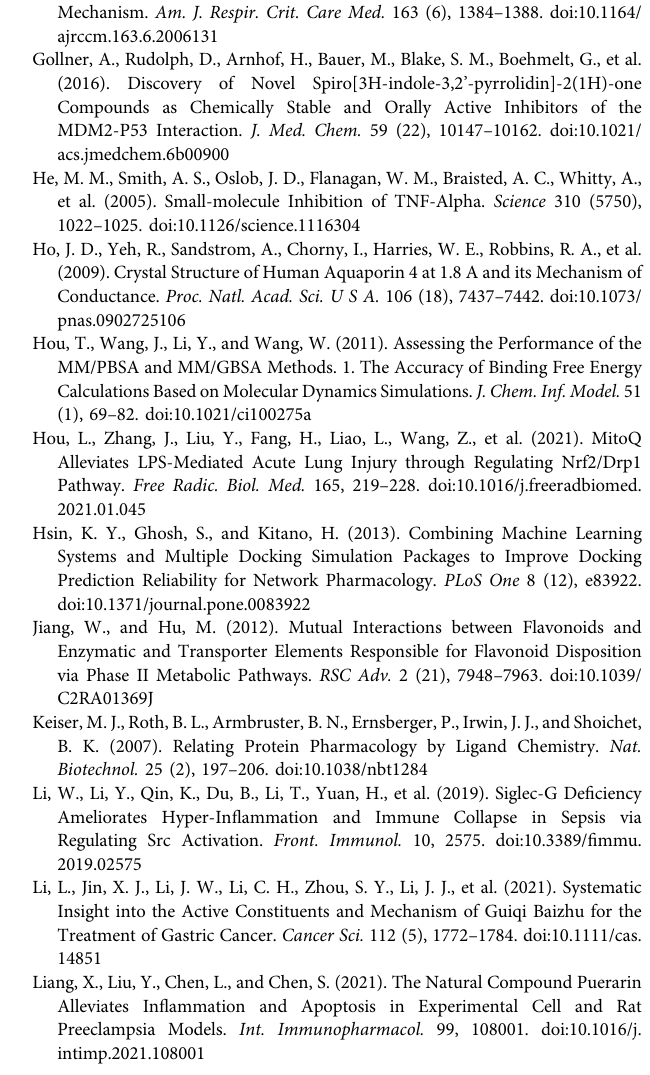
Supplementary Figure S1 | Cell viability for MLE12 after treatments ofHSBDF and key compounds in plasma (cell viability was detected by CCK-8,* P < 0.05 versus blank). Supplementary Figure S2 | Histogram and percentage graph of protein – active compound interaction in molecular dynamics simulation. (B,C) Protein – ligand interaction of rhein and quercetin with IL-6R; (C,D) protein – ligand interaction of rhein and emodin with TNF- α